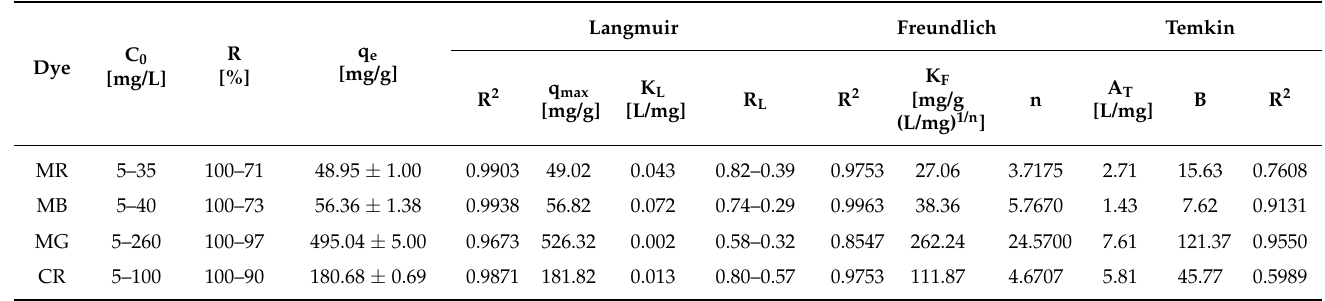
Table 2. Langmuir, Freundlich and Temkin parameters of the adsorption isotherms of organic dyes onto activated carbon—PC5A7.